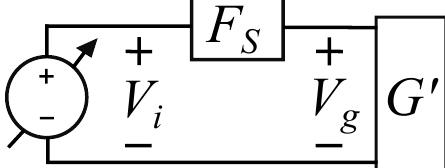
Figure 2. The converter switches can be represented as an ideal voltage source. Series filter components are represented as F S , while parallel filter elements are lumped into the grid to become G (cid:48)